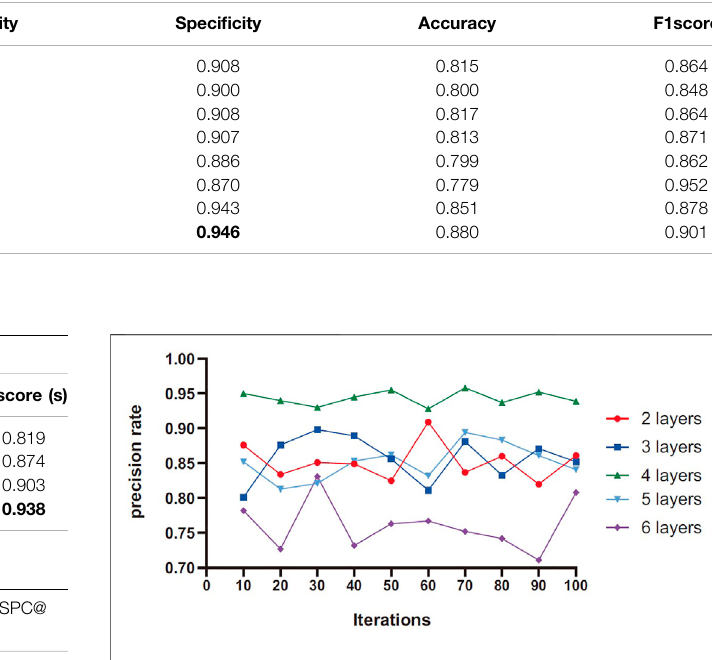
FIGURE 5 | Layer number experimental result